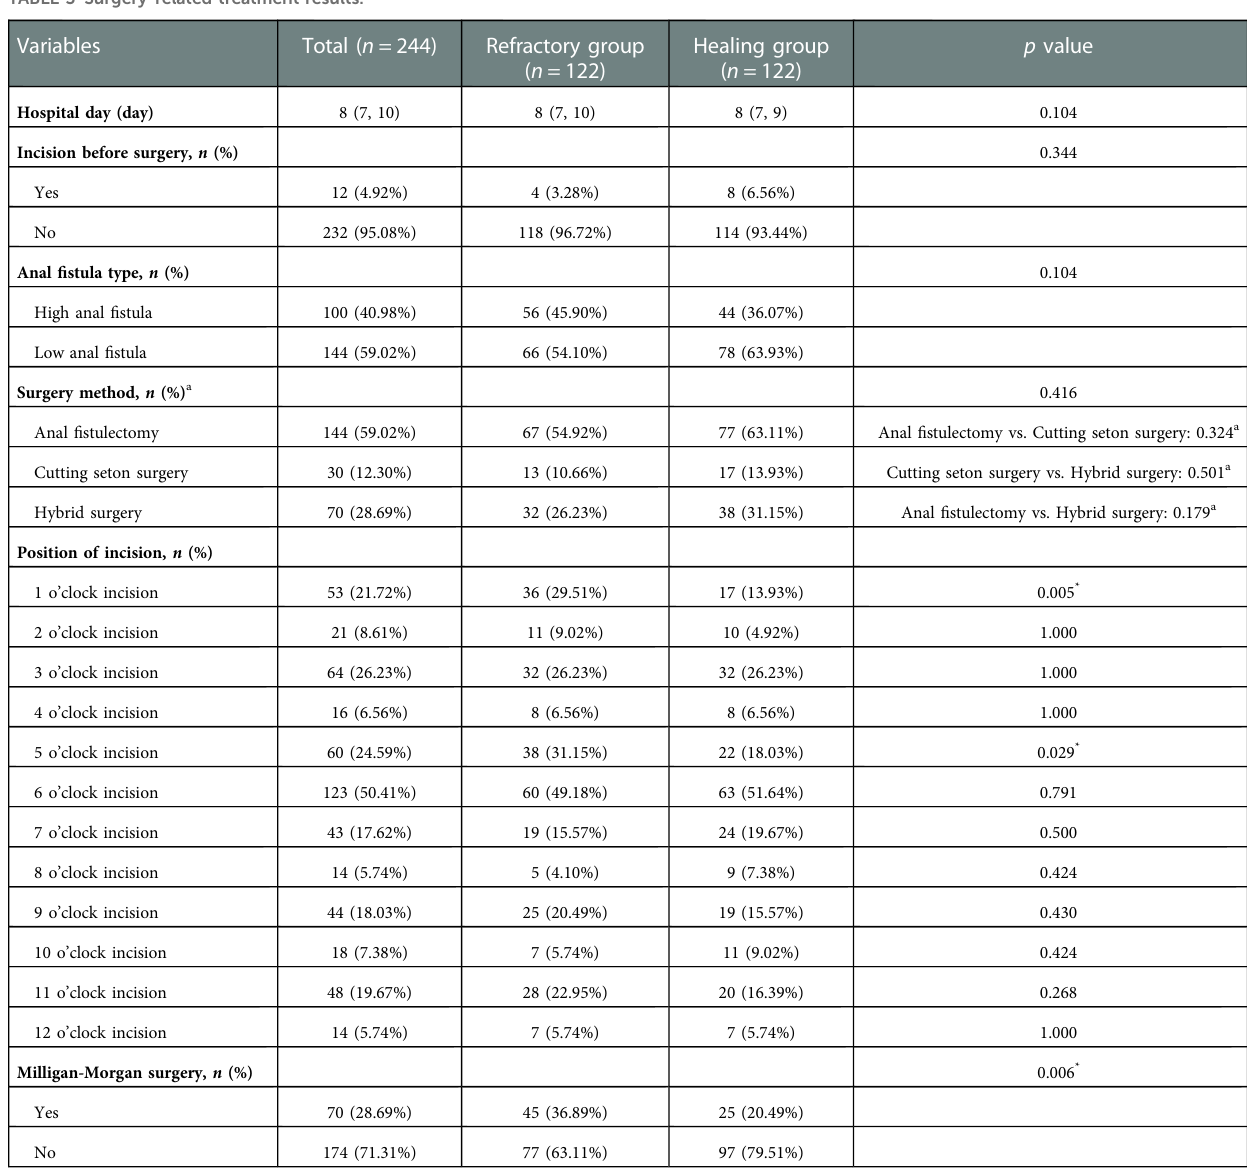
TABLE 3 Surgery-related treatment